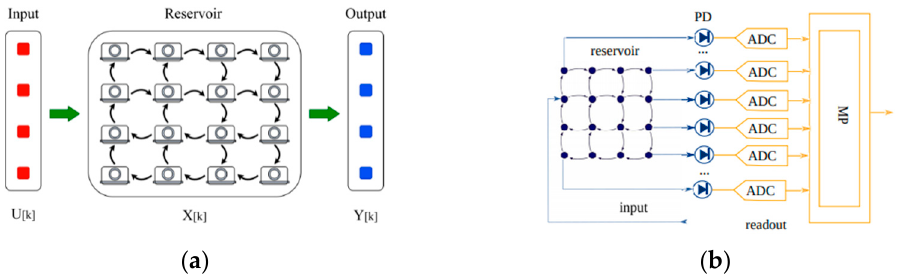
Figure 6. Optical reservoir plan ( a ) MRR structure [36]. The data matrix is input into the reservoir network composed of MRR, and after network circulation, the data matrix is output. ( b ) Silicon-based delay line [37]. The data are input into a network composed of delay lines, which make the front and back input signals interact with each other. PD is used to detect and convert optical signal into electrical signal, which is processed by a micro-processor.